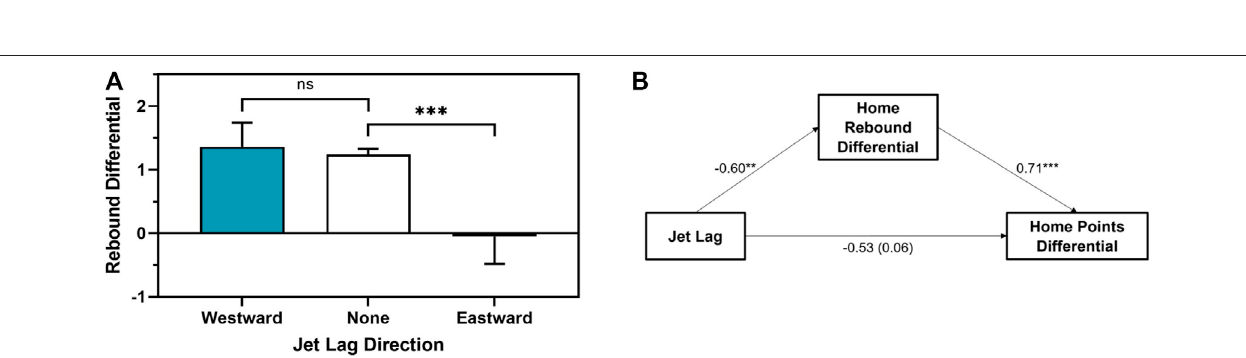
Frontiers in Physiology |